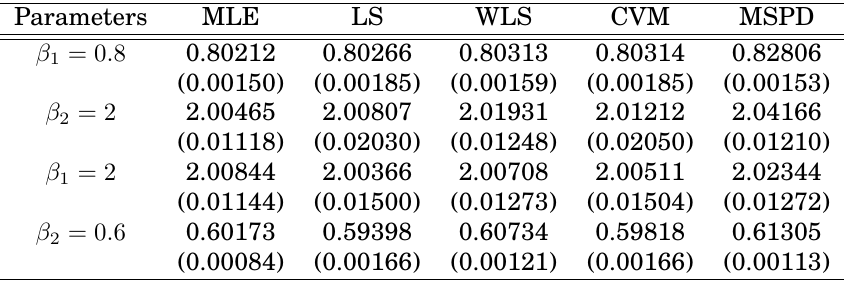
Table 3: AVs and MSEs for ς = 200 .